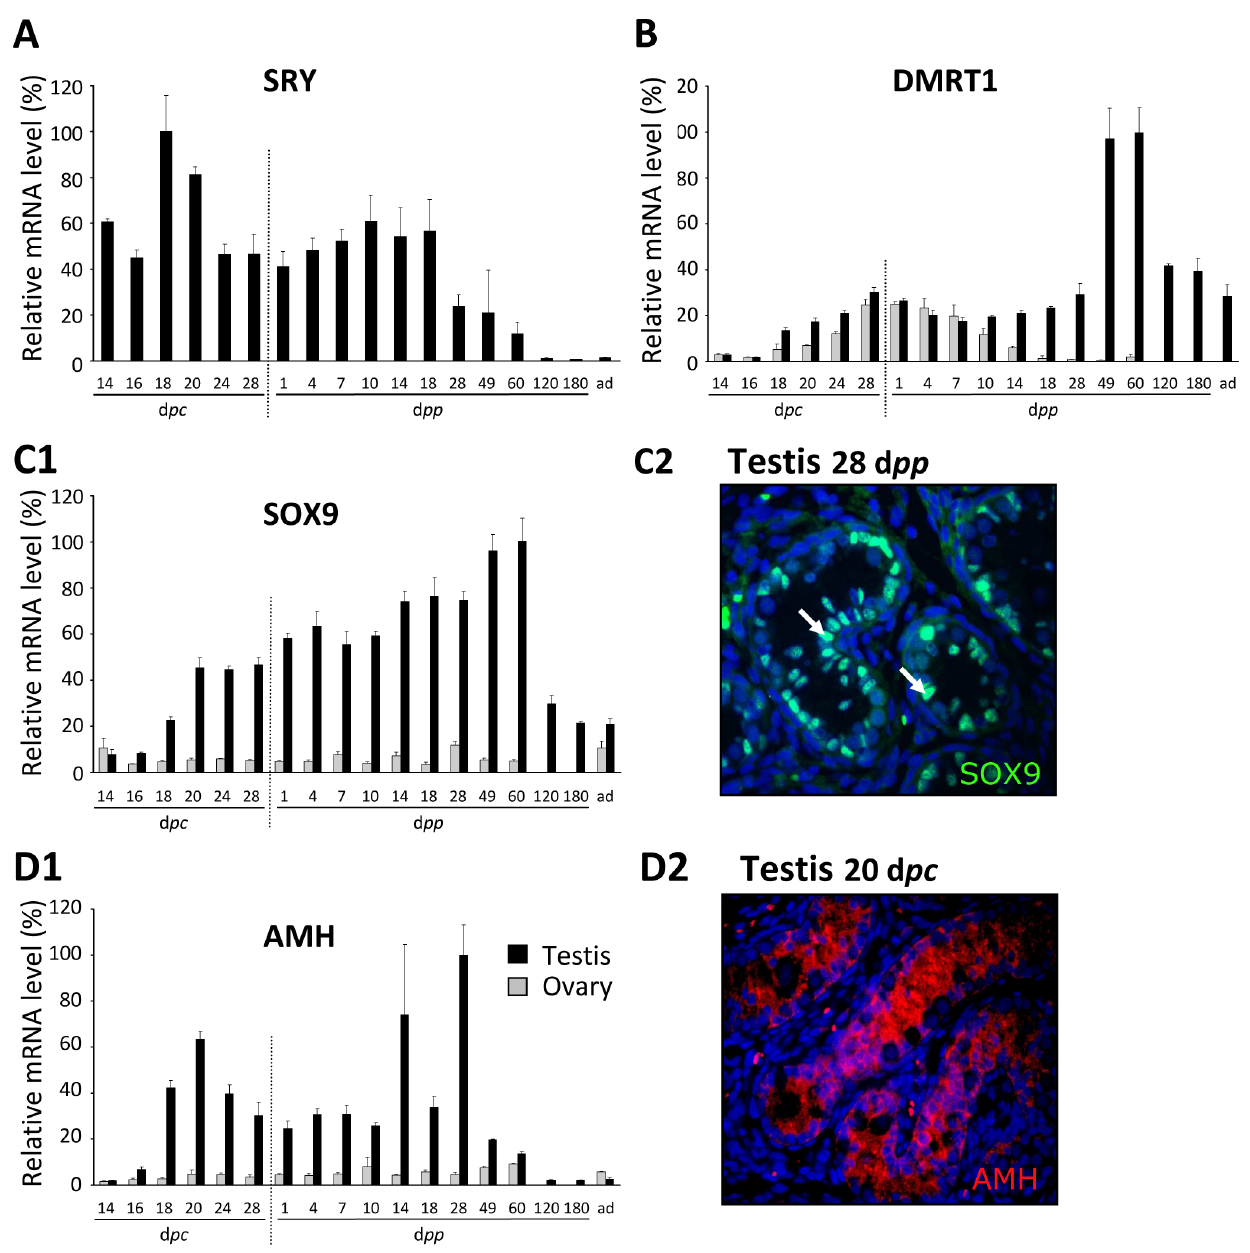
Figure 3. Expression of genes involved in testis differentiation. Expression levels of the SRY , DMRT1 , SOX9 and AMH genes were determined in males (black bars) and females (grey bars) by quantitative RT-PCR, as described in the Materials and Methods. The levels of expression are given as percentages after normalisation to the highest level (100%). Values are means + / 2 sem of expression levels determined on gonads from at least 3 animals per stage. The horizontal scale indicates the age of the rabbit in d pc (days post coitum ) and d pp (days post partum ). ad=adults, 2-year old rabbit. Note that at 120 and 180 d pp , only testes were collected and analysed. C2, D2 : immunofluorescence detection of SOX9 (C2) and AMH (D2) on paraffin sections of gonads. The antibody against SOX9 specifically stains the nuclei of Sertoli cells (male gonad at 28 d pp ). The white arrows label some of the Sertoli cells. The antibody against AMH stains the cytoplasm of Sertoli cells (gonads at 20 d pc ).